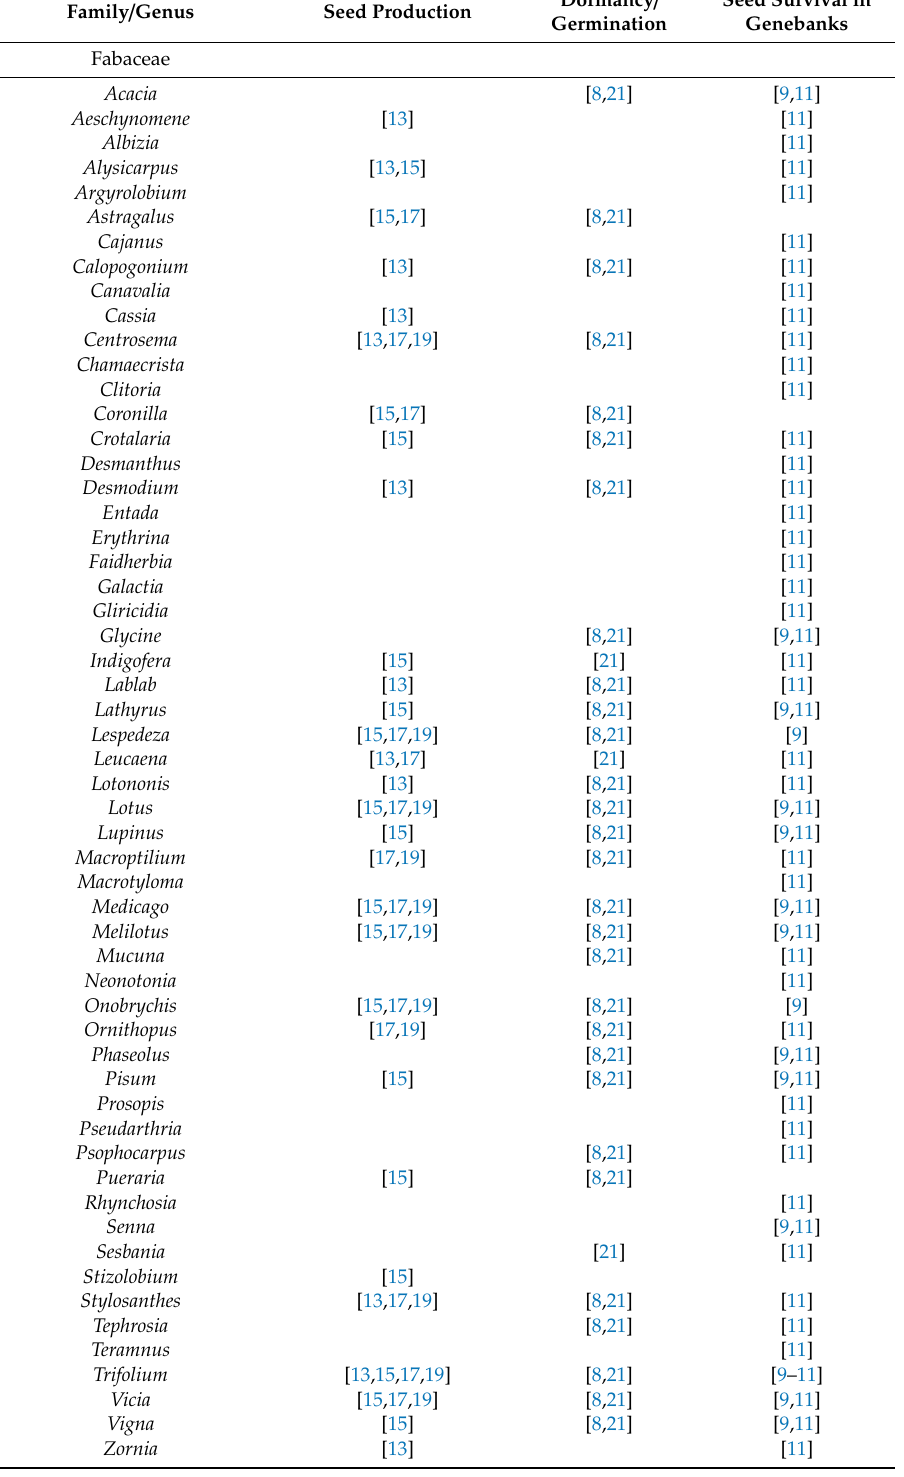
Table 2. Examples of information sources (reference numbers shown) on methods of seed production; dormancy (and dormancy-breaking methods), germination (germination testing and promotion for accession monitoring), and seed survival in genebanks (seed survival periods of di ff erent genera of forage grasses and forage legumes in